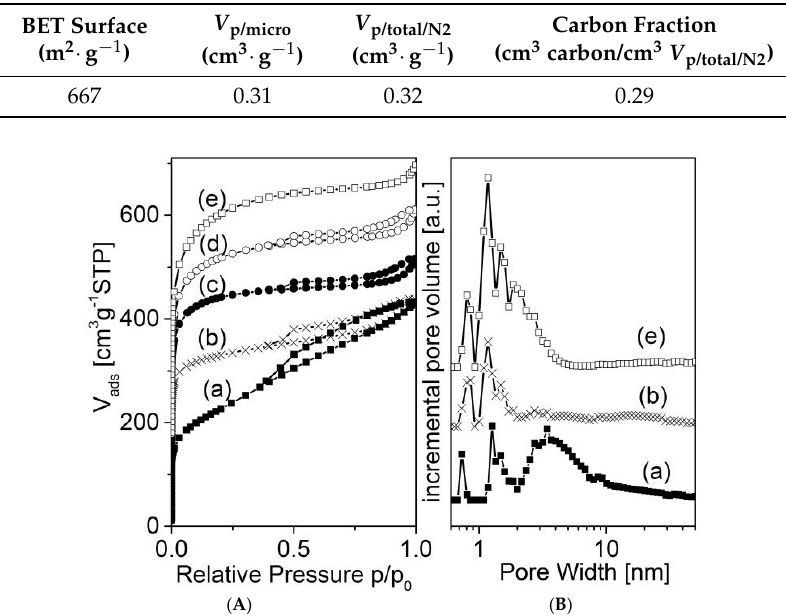
Figure 10. Nitrogen adsorption isotherms ( A ) and according pore size distribution functions (DFT) ( B ) of the zeolite-made tube (a) and the carbon replica tube (b) and, for comparison, of porous concrete-derived carbon 873-0M (c).